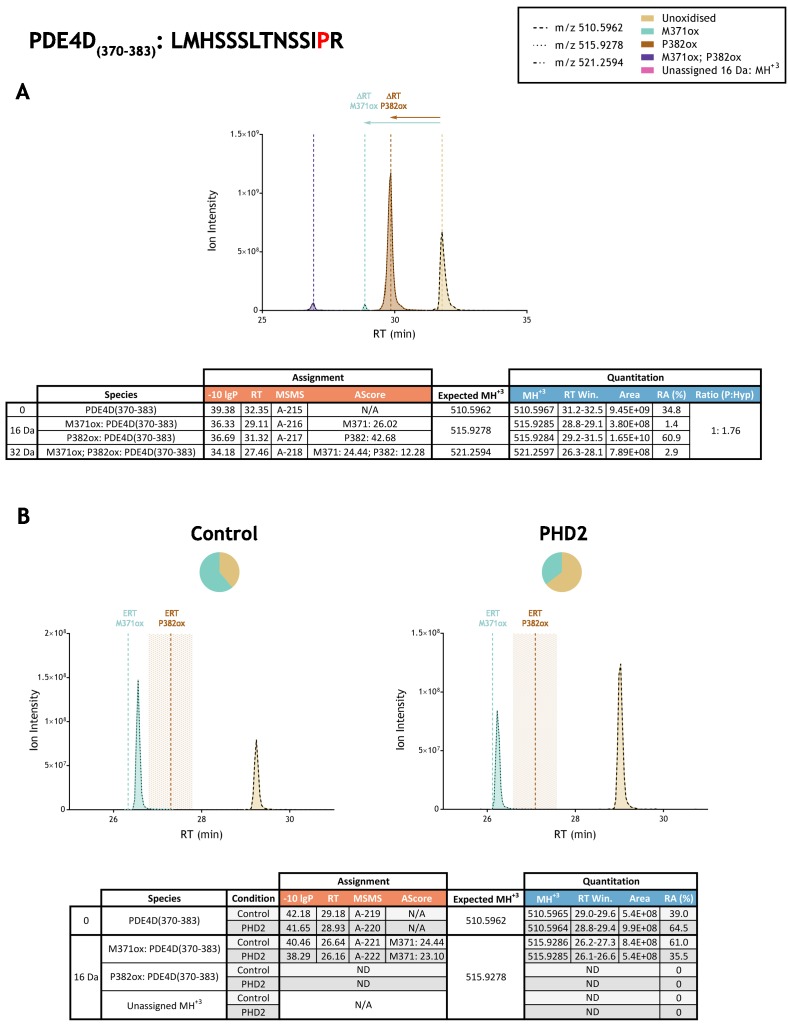
Quantitation of peptide oxidation on PDE4D(370-383) following reaction of full-length phosphodiesterase 4D (isoform 6) with recombinant PHD2.XIC data presented in (A) shows ion intensity and retention time (RT) characteristics of equimolar synthetic peptide standards for unoxidised and P382ox forms of the PDE4D(370-383) peptide. MSMS assigned species are coloured (see inset) and include low abundance non-enzymatic methionine oxidation (M371ox; turquoise); vertical dashed lines define peak maxima used to derive ΔRT values for M371ox and P382ox. Panel (B) shows comparable XIC data for protease-digested IVTT substrate under control (left) or PHD2-reacted (right) conditions. Peaks corresponding to unoxidised and M371ox forms of PDE4D(370-383) were assigned by MSMS; P382ox was not detected. Estimated RT (ERT) values for oxidised peptides, derived from (A), are indicated by dashed vertical lines and show IVTT-derived M371ox eluting close to the ERT; shading applied to ERT P382ox corresponds to a 1 min RT window. Unassigned ions of compatible mass over charge for hydroxylation were not observed across the elution window. Quantitative data for observed species are presented as pie charts with XIC data. Assignment and quantitation data are tabulated below each panel, table headers are as follows: (−10lgP) significance score of leading assignment at given (RT) with ambiguity score (AScore) for PTM localisation and reference to primary MSMS data in Supplementary file 1. Quantitative data reports ion counts (Area) of observed masses (MH+3) integrated over time (RT Win.), expressed as relative abundance (RA). Data on detection efficiency for synthetic peptides (Panel A, P: Hyp) is an aggregated ratio of prolyl (P) to hydroxyprolyl (Hyp) containing species.